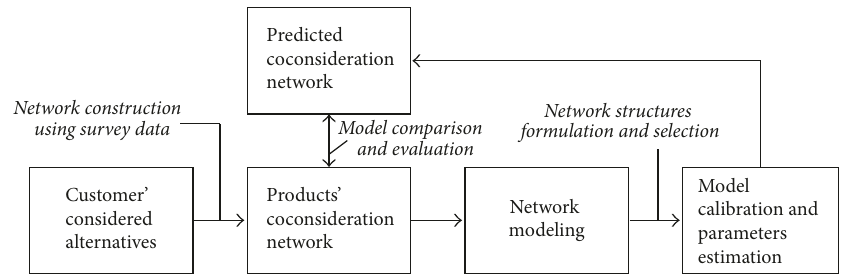
Figure 1: The research approach and the research